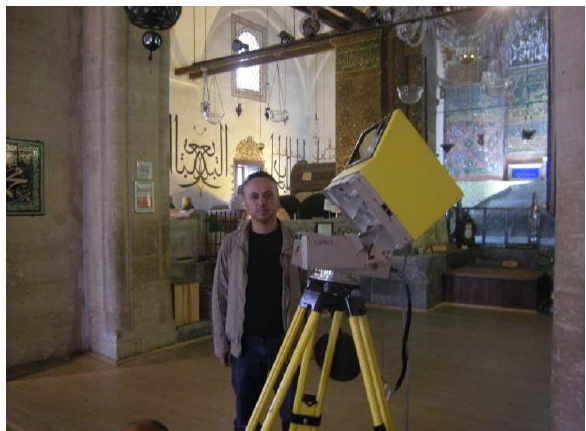
Figure 2. Laser scanning in Huzur-ı Pir section of Mevlana Museum.